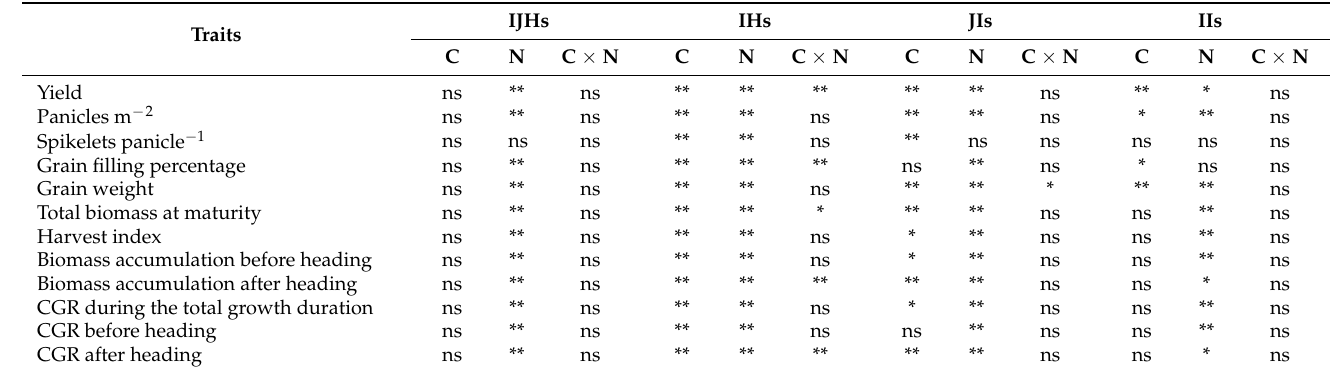
Table 3. Analysis of variance on yield-related traits of indica-japonica hybrids (IJHs), indica hybrids (IHs), japonica inbreds (JIs), and indica inbreds (IIs) under different N levels in each group of rice. Traits